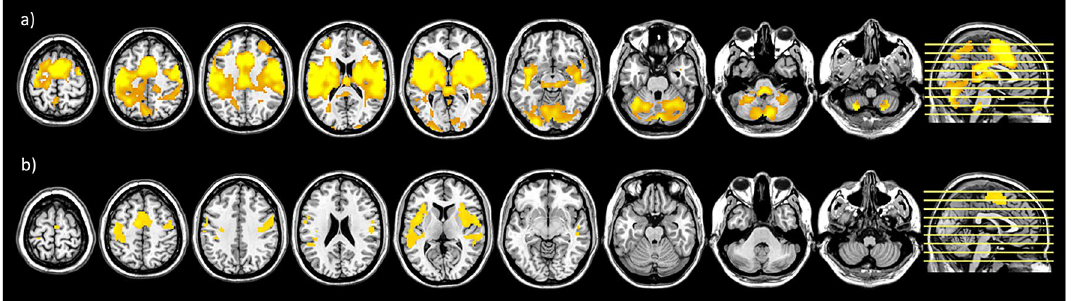
Figure 3. Presentation of activation clusters derived from group-level analysis. ( a ) Activations derived from one-sample t test of T2: painful tooth clenching activated bilateral insula (anterior and posterior), bilateral thalamus, bilateral S2, bilateral inferior frontal gyrus, bilateral putamen, bilateral inferior parietal lobule, middle cingulate gyrus, bilateral middle frontal gyrus, bilateral superior frontal gyrus, bilateral cerebellum and left M1; ( b ) Activations derived from the paired t test comparing T1 versus T2: painful tooth clenching activated left S1, bilateral S2, bilateral M1, SMA, right rolandic operculum, bilateral insula (anterior and posterior); data are thresholded at p < 0.001, FWE cluster corrected.